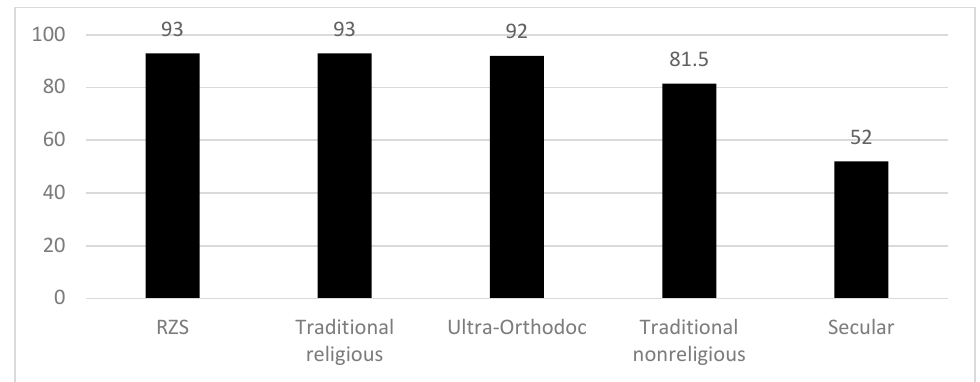
Figure 10. Agree that the Jewish citizens of Israel should have more rights than non-Jews (%). ( Source: Israeli Democracy Index, 2021).